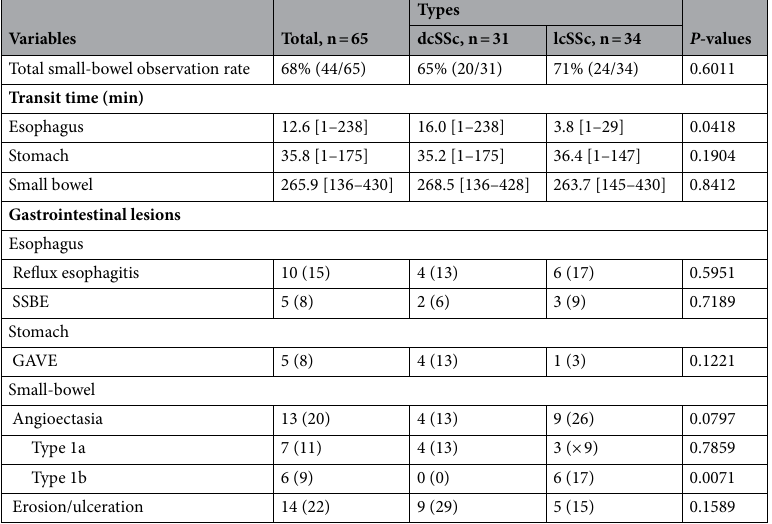
disease duration. Anti-platelet drugs were used in three dcSSc patients and five lcSSc patients (p = 0.5353), whereas NSAIDs were used in three dcSSc patients and seven lcSSc patients (p = 0.2168). Regarding chief com- plaints, 50% (33/63) of patients with SSc were asymptomatic. There was a significant difference in mRSS. This is consistent with the disease backgrounds. The average capsule transit time of the esophagus was significantly longer in dcSSc patients than in lcSSc patients (16.0 vs. 3.8 min, p = 0.0418) (Table 2). The average capsule transit time in the stomach and small bowel was not significantly different between the two groups (stomach: 35.2 vs. 36.4 min, p = 0.1904; small bowel: 268.5 vs. 263.7 min, p = 0.8412). There was no significant difference between the two groups in the total small-bowel observation rate (65% [20/31] vs. 71% [24/34]). The frequency and characteristics of gastrointestinal lesions are shown in Table 2. Small-bowel lesions were detected in 42% (27/65) of patients with SSc; 13 patients (20%) had angioectasia, and 14 (22%) patients had erosion/ulceration. Ten patients with SSc (15%) had reflux esophagitis, and five (8%) had short-segment Barrett’s esophagus. Five